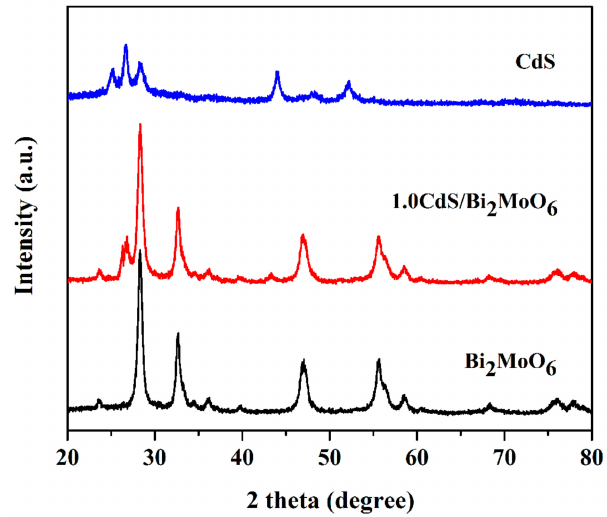
Figure 1. XRD patterns of Bi 2 MoO 6 , CdS, and 1.0CdS/Bi 2 MoO 6